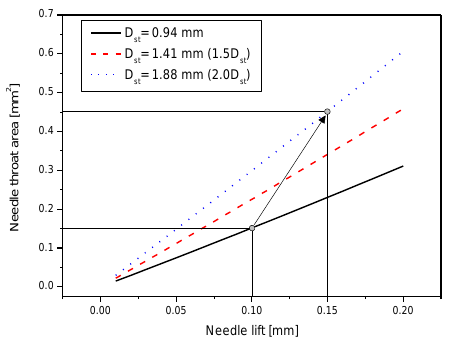
Figure 8. Area ratio according to needle lift.